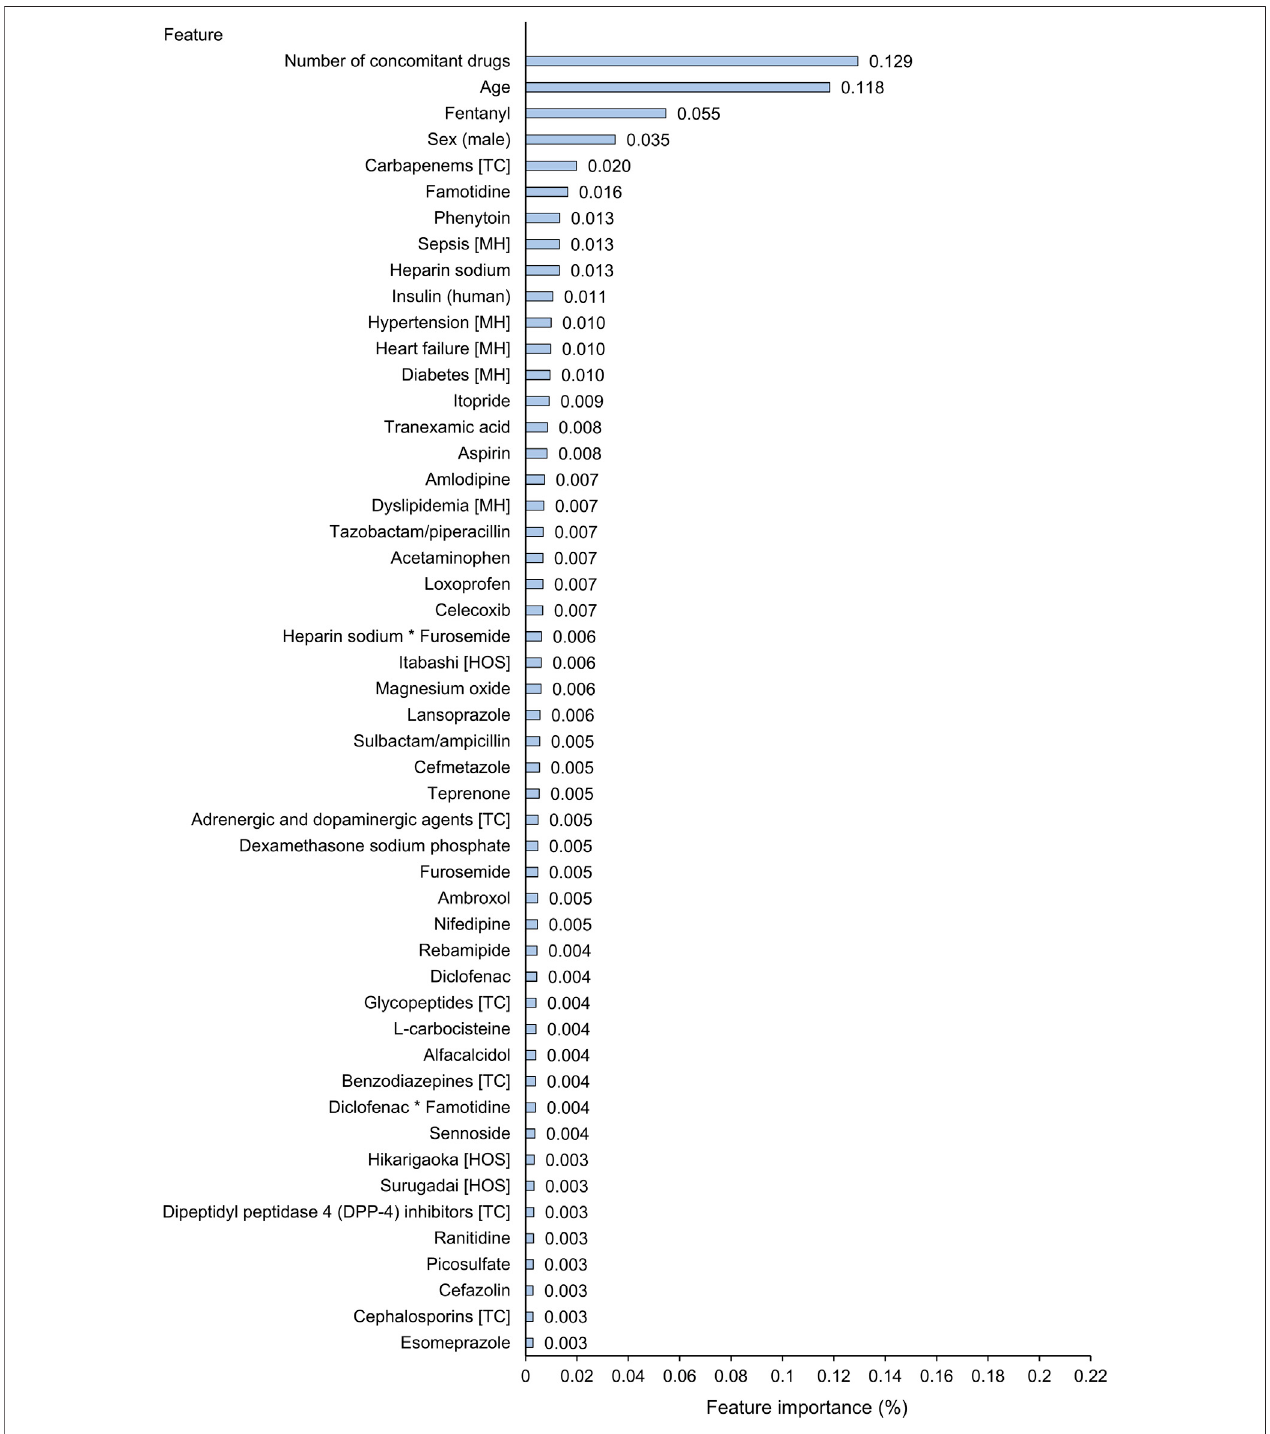
FIGURE4| Top50importantfeaturesforpredictionofabnormalelevationofalanineaminotransferaseinextremegradientboosting(XGBoost)treemodel.The fi rst column includes the top 50 important features of all the features that were actually used in the XGBoost tree model. Feature importance (Gain) score indicates how important each feature was in the construction of boosted decision trees within the XGBoost model. A higher value of this metric when compared to another feature suggests that it is relatively more important for construction of a predictive model. The sum of all importance scores included in a trained XGBoost tree model is 1. The symbol * indicates a product term of two drugs. HOS, hospital; MH, medical history; TC, therapeutic class.